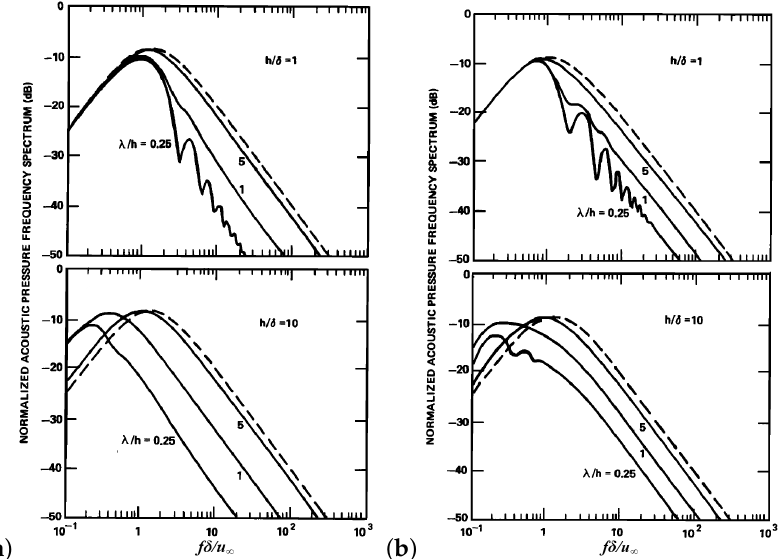
Figure 10. Normalized acoustic pressure frequency spectrum of noise produced by different trailing edge serrations ( - - - for an unserrated edge, reprinted from [114] with permission from AIP Publishing): ( a ) sawtooth serrations; and ( b ) sinusoidal